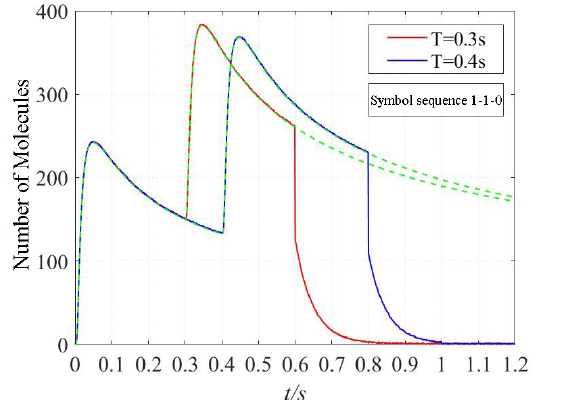
Figure 3. The comparison of CIR curves between the diffusion with photolysis and without photolysis. The solid line denotes the signal when the photolysis reaction happens, while the dotted line denotes the signal when the molecules diffuse without photolysis reaction. t / s denotes that the unit of time is second. The red line denotes a symbol sequence with a time duration of 0.3 s, and the blue line denotes a symbol sequence with a time duration of 0.4 s.